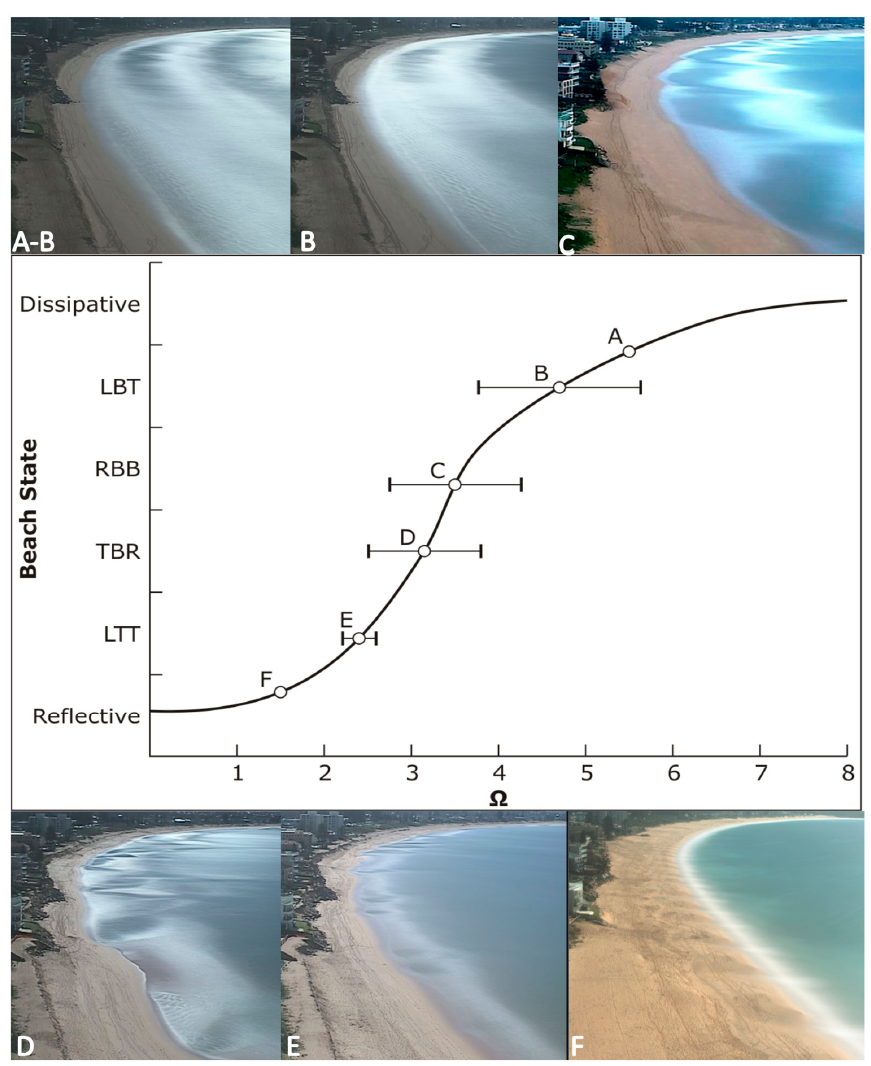
Figure 5. The full range of Morphodynamic Beach States observed at Narrabeen-Collaroy using the Argus station. (top, l–r) Example images of instantaneous beach states. ( A , B ): Dissipative—Longshore Bar Trough (LTB); ( B ): Longshore Bar Trough; ( C ) Rhythmic Bar Beach (RBB). (middle) Beach state as a function of dimensionless fall velocity ( Ω ). (bottom, l–r) ( D ) Transverse Bar Rip (TBR); ( E ) Low Tide Terrace (LTT); ( F ) Reflective.